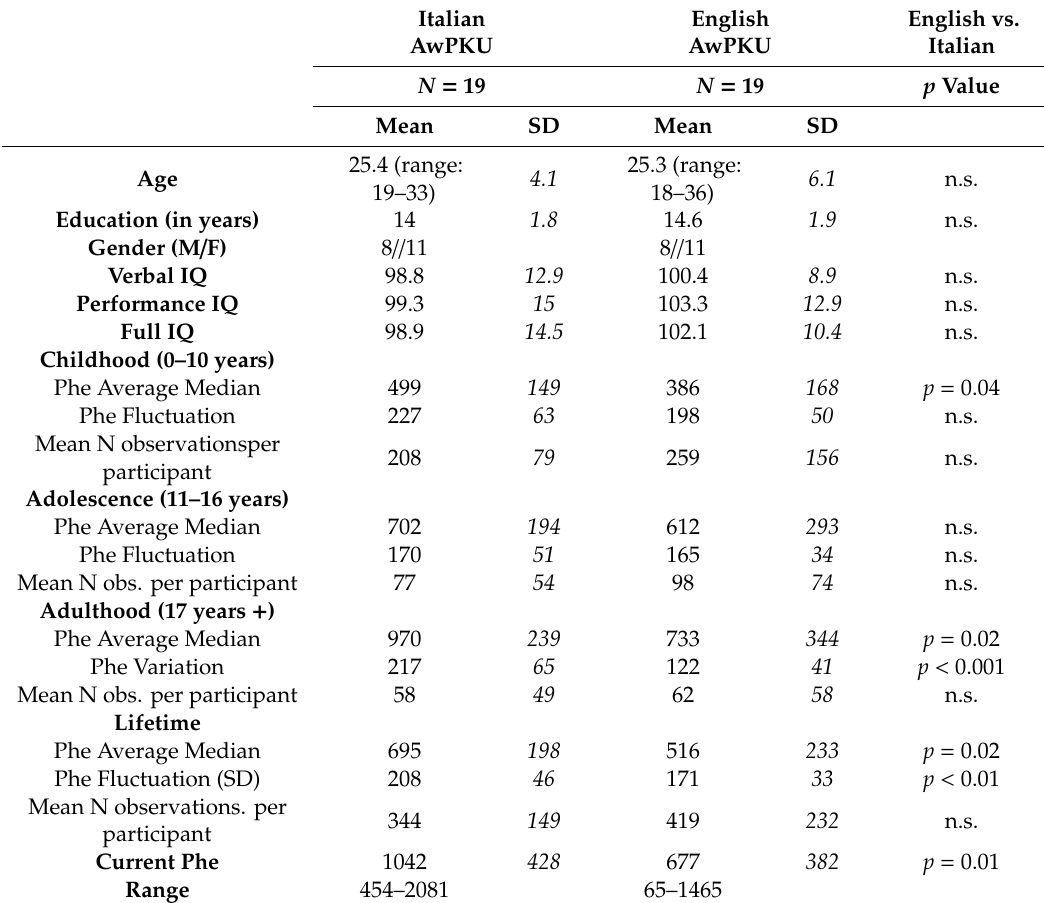
Table 1. Demographic Variables in Terms of Age, Gender, Years of Education and Metabolic Control across Ages for the Two Matched Groups of Italian and English AwPKU. Blood Phe measured in µ mol / L.